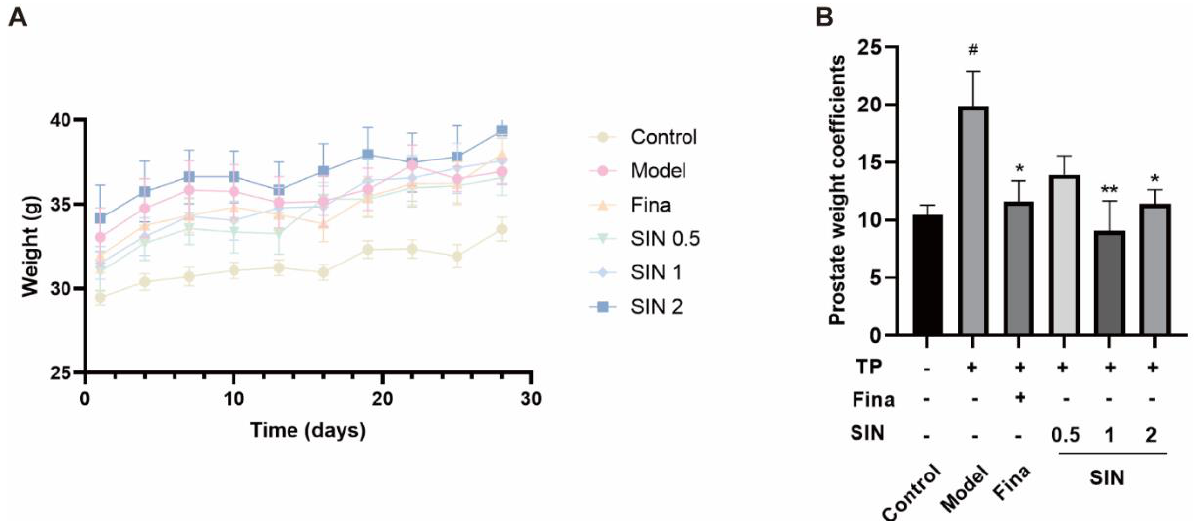
Figure 3. Effect of SIN administration on prostatic enlargement in mice with testosterone propionate (TP)-induced BPH. ( A ) Plot of body weight change in mice. The bodyweight of mice was recorded every 3 d. ( B ) Prostate weight coefficient in mice. Prostate-gland weight coefficient = wet weight of prostate gland (mg)/bodyweight of mice (g) × 10. Data are the mean ± SEM. # p < 0.05 versus the control group; * p < 0.05, ** p < 0.01 versus the model group. Fina, finasteride; SIN, sinomenine hy- drochloride.